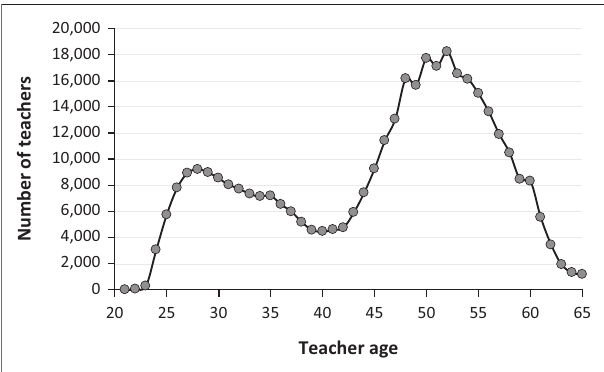
FIGURE 4: Projected teacher age in South Africa,